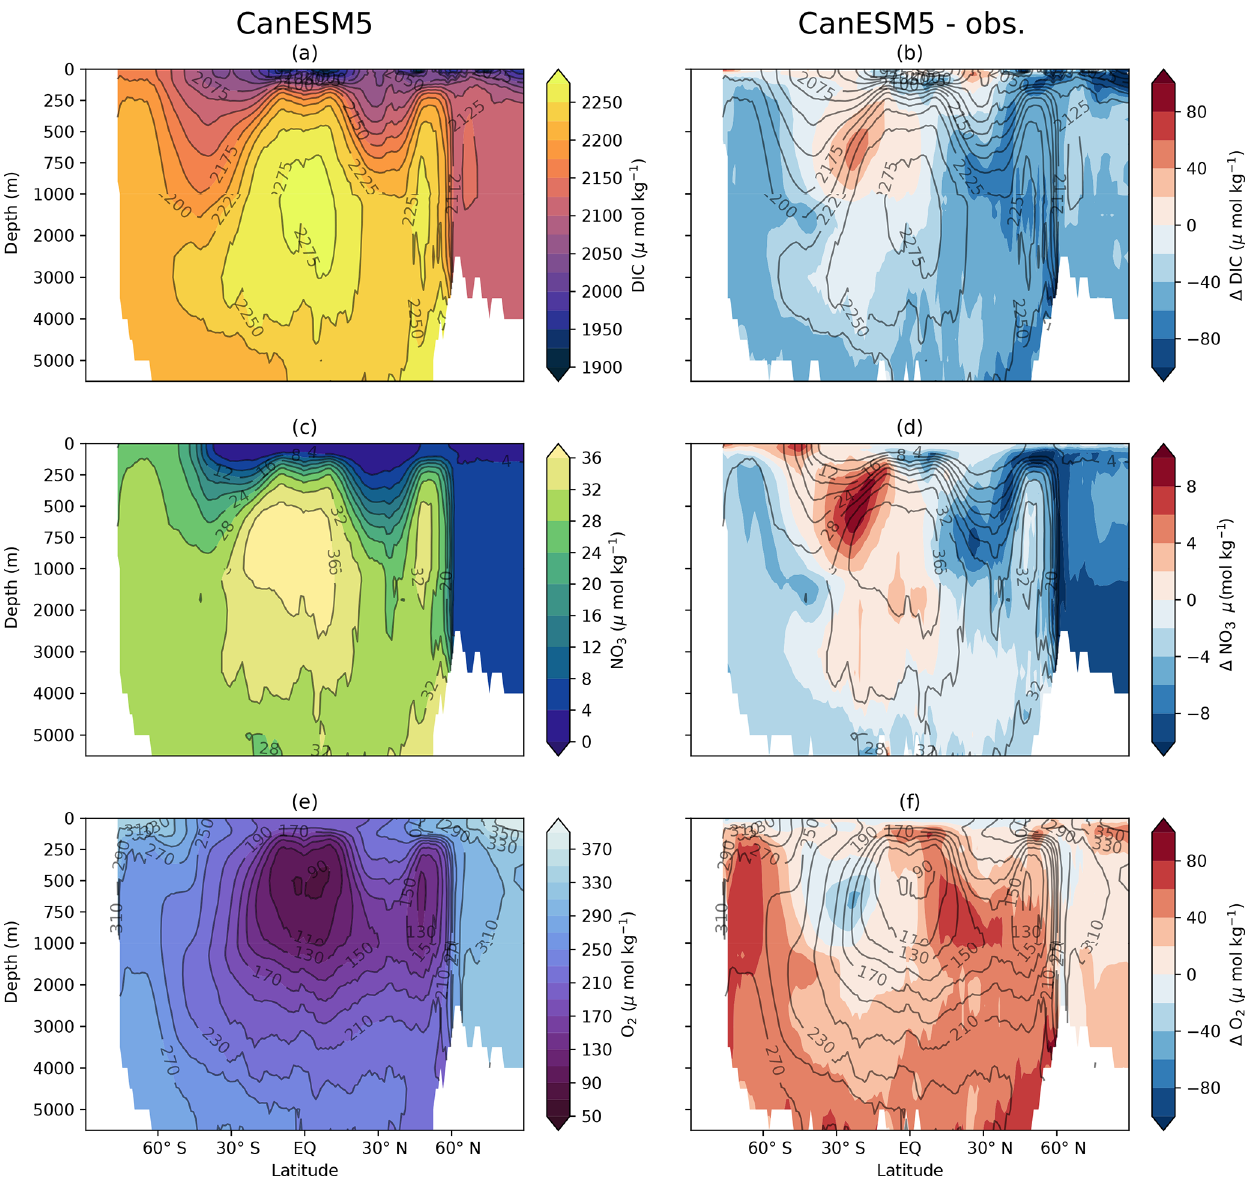
Figure 21. Zonal-mean sections of (a) dissolved inorganic carbon, (c) NO 3 , and (e) O 2 in CanESM5, averaged over 1981 to 2010, and their biases relative to GLobal Ocean Data Analysis Project (GLODAP) v2 (b, d, f) . Note that the depth scale on the y axis is